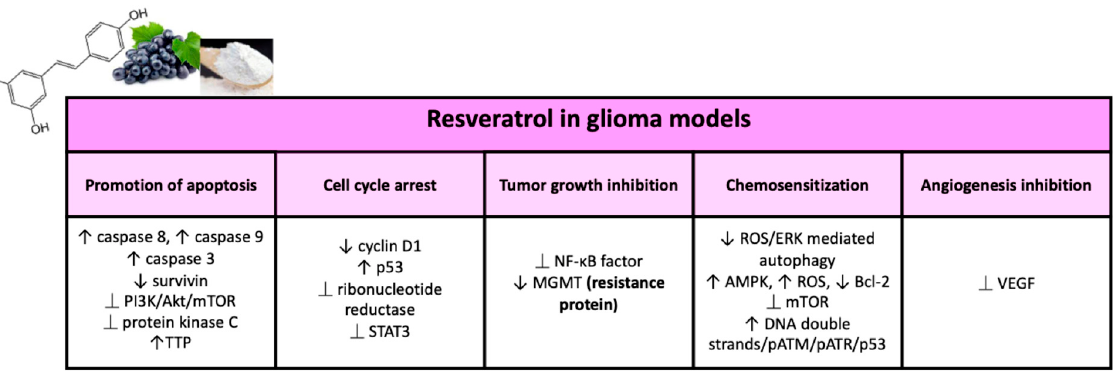
Figure 4. Major effects of resveratrol on glioma models in preclinical studies.